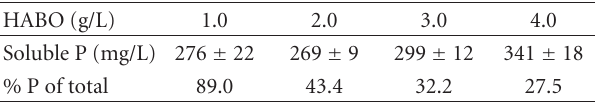
Table 4: E ff ect of animal bone char concentration on phosphate solubilizing e ffi ciency of k-carrageenan-entrapped Yarrowia lipolyt- ica in a 96-hour single-batch cycle. HABO (g/L) Soluble P (mg/L) 276 ± 22 Values are means of ± SE of 3